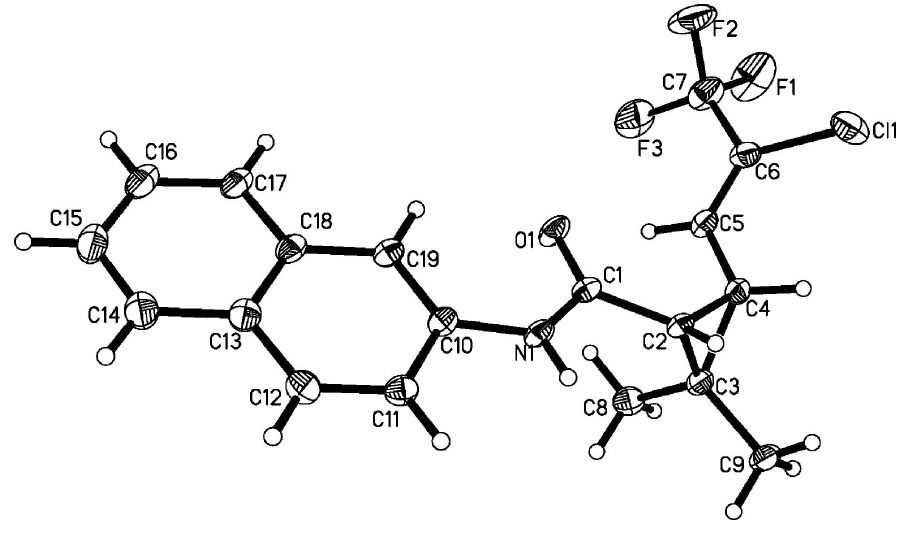
Figure 1 The molecular structure of (I), methanol, drawn with 30% probability ellipsoids. H atoms are drawn as spheres of arbitrary